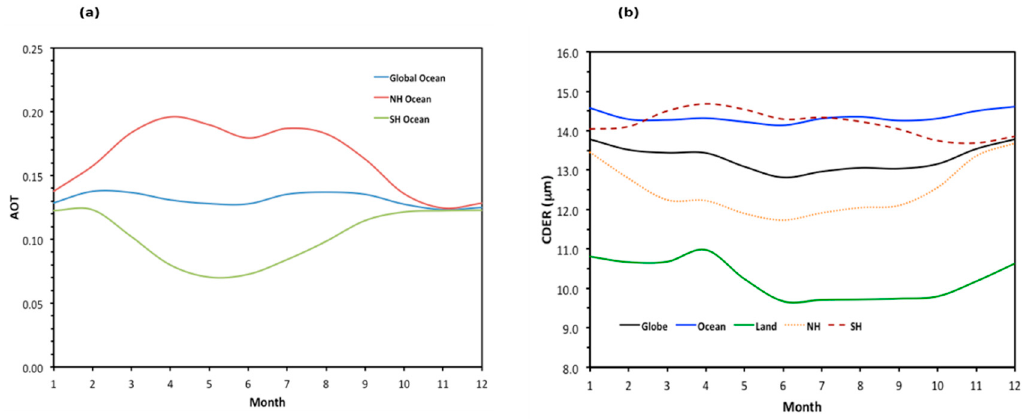
Figure 6. Long-term averaged ( a ) AOT and ( b ) CDER for each month in several geographical areas.